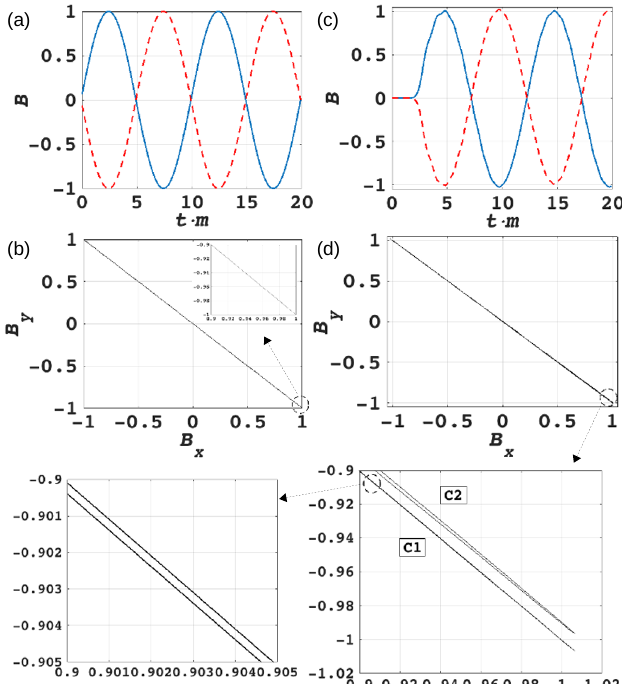
Figure 10 . Vacuum Kerr effect induced FEL polarization conversion from linear to elliptical-like states. (a) The magnetic field components in the source plane, where the bule solid line denotes B x and the red dashed line denotes B y . (b) The trace of magnetic field vector in the source plane is a line segment, which means that the incident FEL plane wave is linear polarized (fine structure of the trace can be found in the inset). (c) The magnetic field components in the target plane, where the bule solid line denotes B x and the red dashed line denotes B y . (d) The trace of magnetic field vector in the target plane exhibits elliptical shape with varying parameters (insets illustrate fine structures of the trace, where C1 and C2 denote the first and the second cycles of the beam respectively), which means that the Dirac vacuum exhibits birefraction property and the birefraction index is time dependent. The magnetic field vectors plotted here are normalized by the incident wave. ( e/m = 0 . 2 , ∆ x i = 0 . 1 /m, ∆ t = 0 . 5∆ x i , ω = 0 . 2 πm, N t = 400 , N x = N y = 40 , N z = 20 , N e = 3600